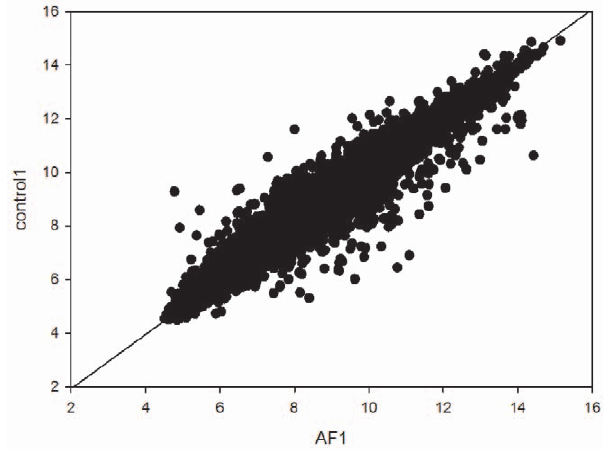
Figure 2. Discrimination plane obtained combining FL2A and FL2B. The points in the plot correspond to individual patients (N=normal patients; AF= atrial fibrillation patients). The plot is spanned by the two most relevant discriminating factors obtained from the two chips. The discriminating line is the result of the application of linear discriminant analysis on the FL2A and FL2B space.